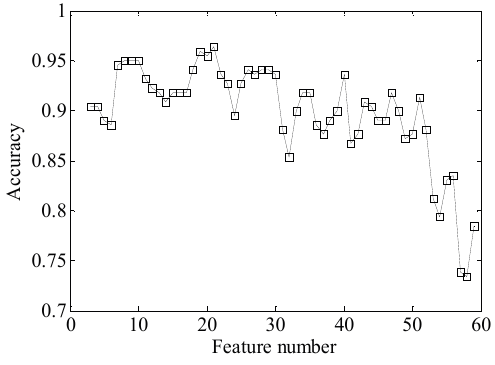
Figure 11. Classification accuracy of different feature